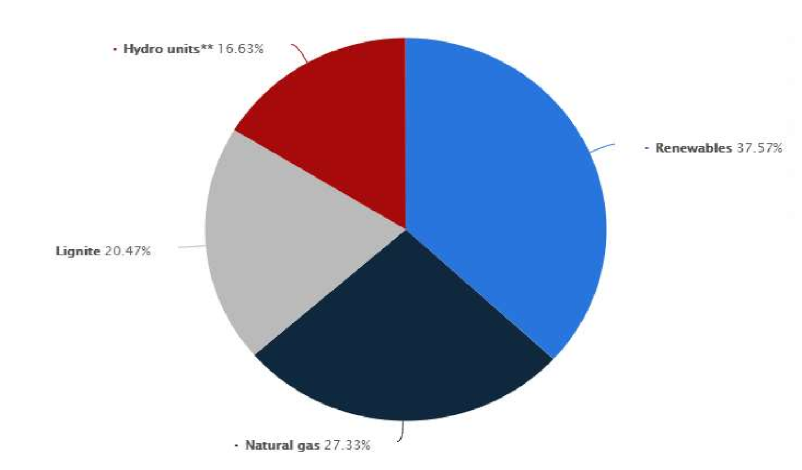
Figure 6. Distribution of installed energy capacity in Greece as of June 2020, by source ** (in